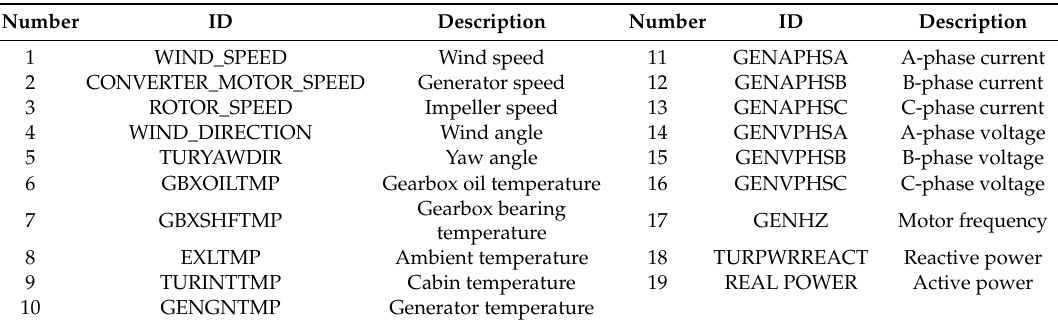
Table 1. Nineteen feature parameters.